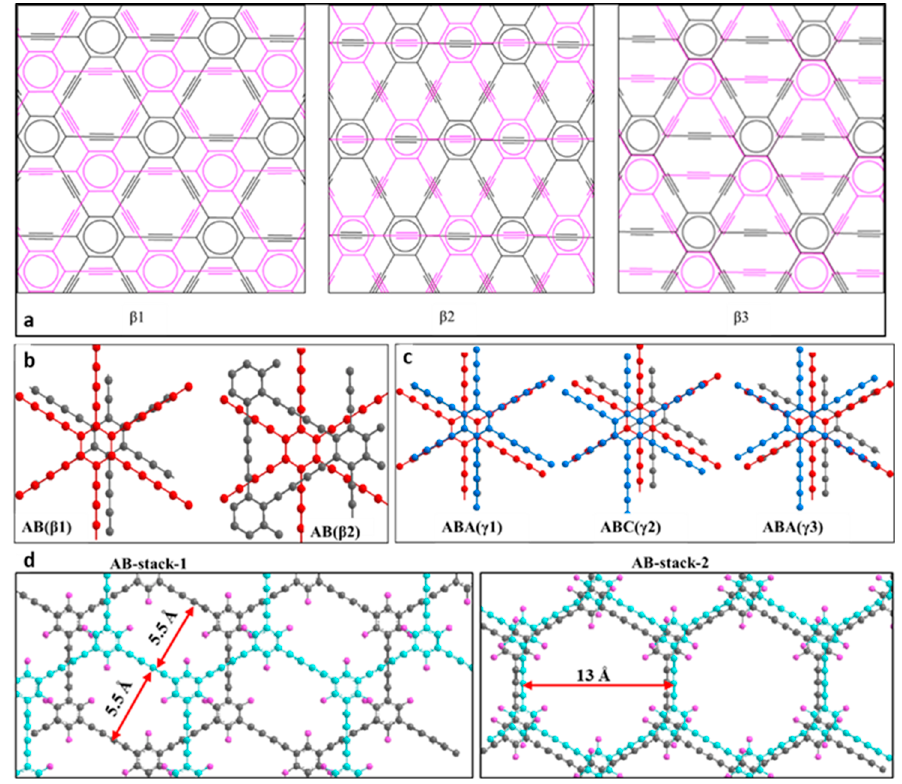
Figure 16. ABA stacking arrangements of 3D graphyne. The A and B sheets are represented by grey and pink structures ( a ). Redrawn [136]. ( b ) Optimized arrangements of double-layer GDY labeled AB( β 1) and AB( β 2) (red top layer and grey bottom layer, respectively); ( c ) three potential forms of the trilayer GDYs: ABA( γ 1), ABC( γ 2), and ABC( γ 3) arrangements (blue top layer, red middle layer, and grey bottom layer). Redrawn [138]. ( d ) AB-1, AB-2, and AB-3 represent structures of bulk GDY. Red arrows show the directions of the in-plane shift of two sheets in the cell. Redrawn [108].